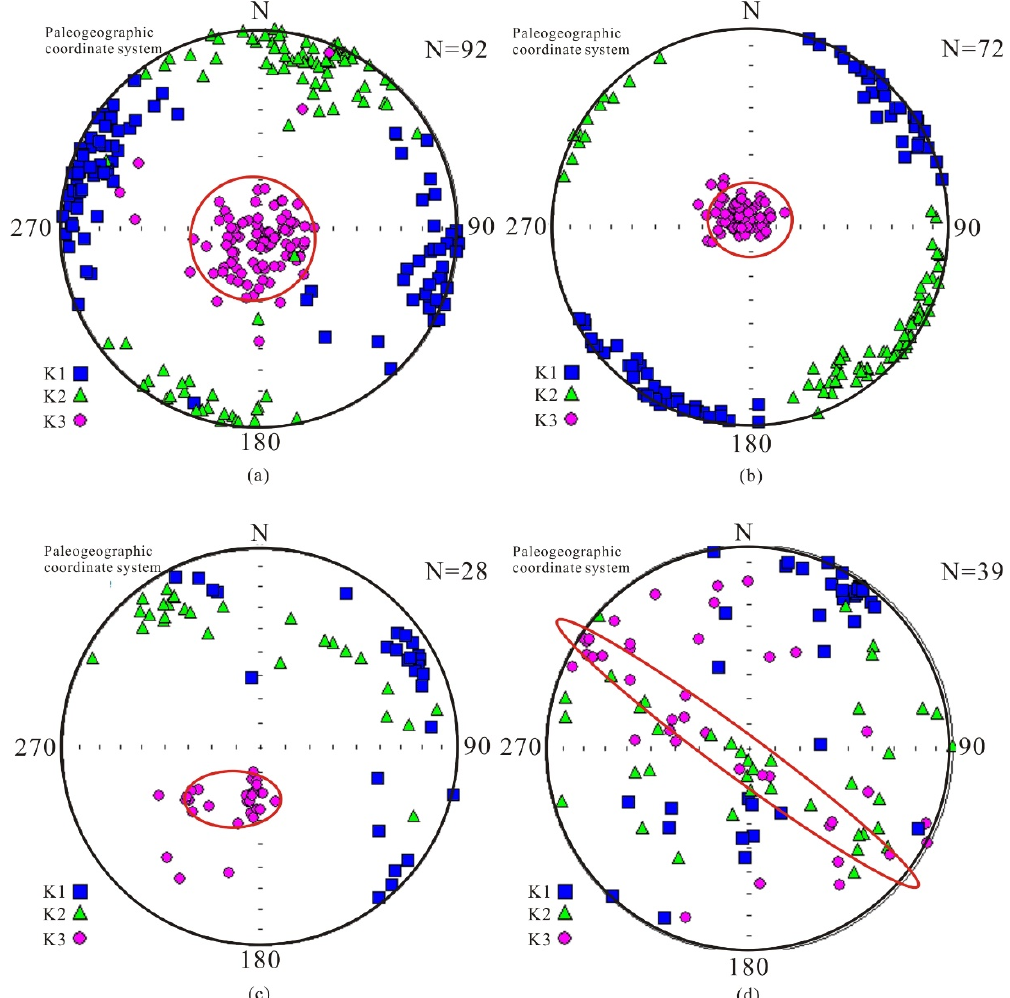
Figure 8. Characteristics of magnetic fabric for the sandstones from different sampling points in the Nyima Basin of Jingzhushan Formaiton in the Late Cretaceous. ( a ) Sedimentary magnetic fabrics indicates NW trending paleocurrent; ( b ) Sedimentary magnetic fabric indicates ES trending paleocurrent; ( c ) Sedimentary magnetic fabric of weak current indicates NE trending paleocurrent; ( d ) Strain magnetic fabric. Red circle represents the direction of extrusion stress.